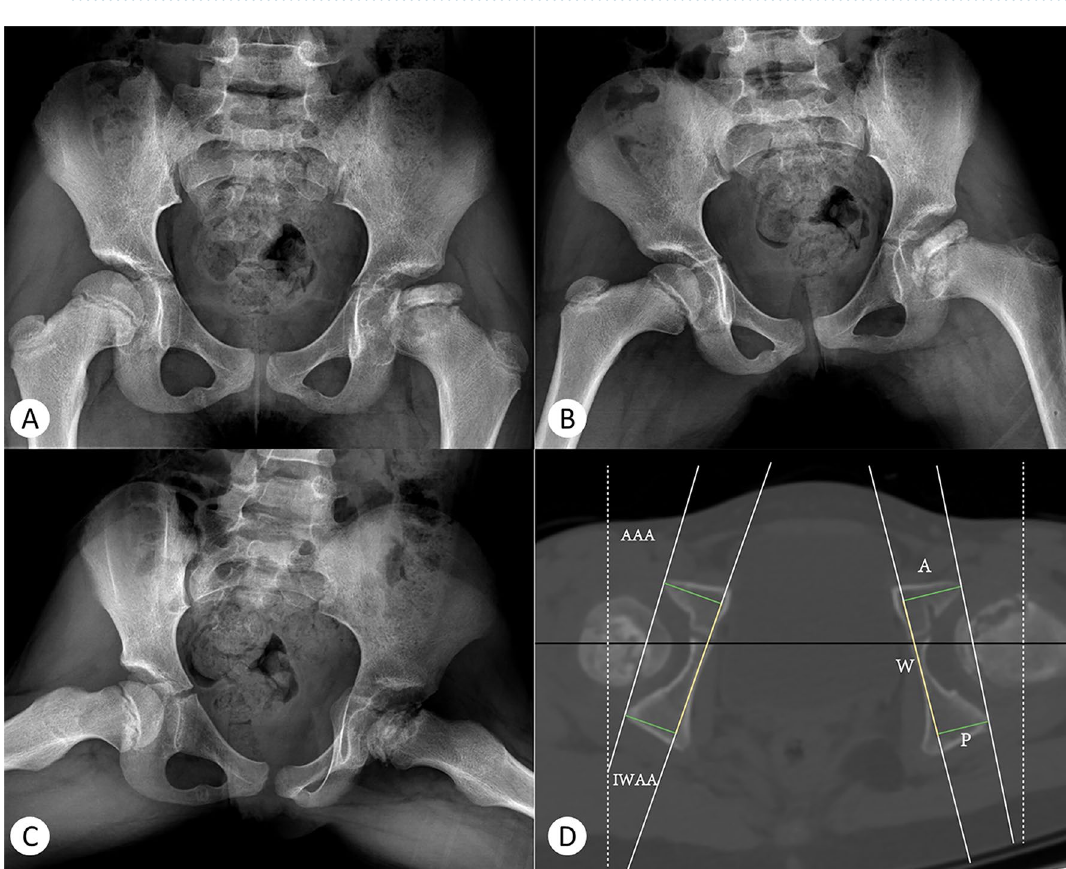
Figure 5. An eight-year-old girl with Legg–Calve–Perthes disease in the left hip. The anteroposterior pelvis radiograph ( A ), Von-Rosen pelvis radiograph ( B ) and frog pelvis radiograph ( C ) show that patient was in Waldenström II stage, Herring B stage and Catterall III